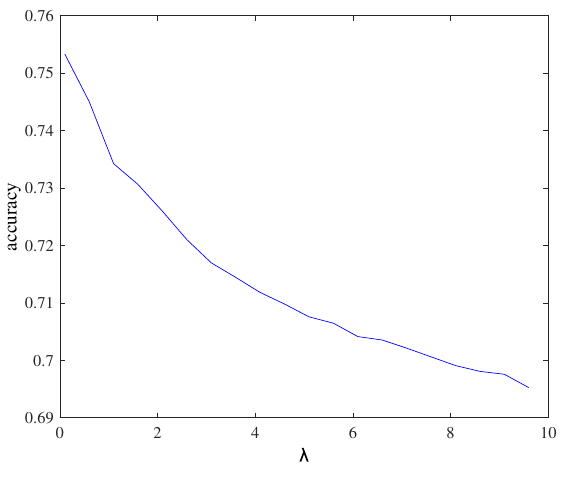
Figure 5. The influence of the regularization parameter on the classification accuracy for the Flevoland I